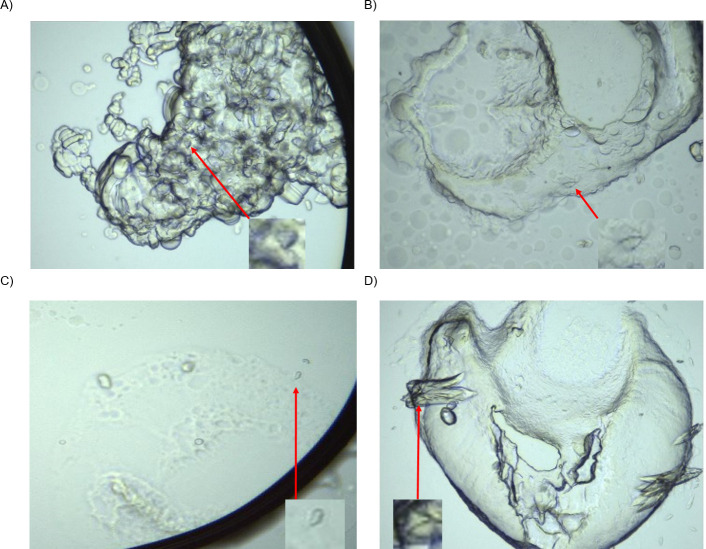
Microscopic images of the LCP crystallization attempts.A) S1P1, precipitant: 0.2 M CaCl2, 0.1 M HEPES pH 7.5, 30% (w/v) PEG 4000. B) S1P1, precipitant: 1 M (NH4)2SO4, 0.1 M HEPES pH 7.0 and 0.5% (w/v) PEG 8000. C) GPR3, precipitant: 0.1 M BIS-TRIS pH 5.5 and 2 M (NH4)2SO4 as crystallization condition. D) GPR3, precipitant: 0.1 M 2-(N-morpholino)ethanesulfonic acid (MES) pH 6.5 and 0.6 M Zn(CH3COO)2 as crystallization condition.